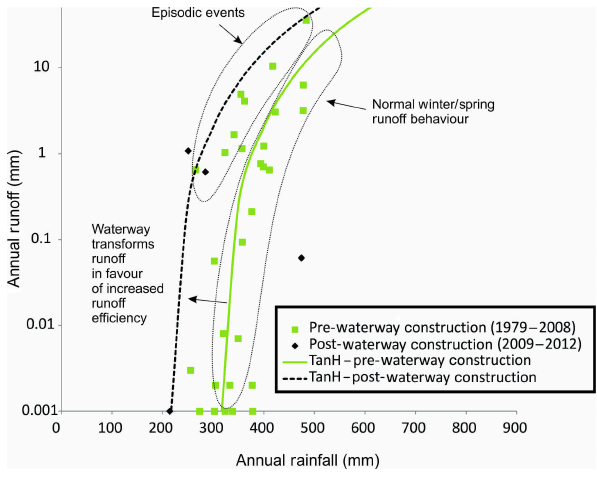
Figure 5. The annual rainfall–runoff data show the role that micro- topography plays within low-gradient drylands, with a pronounced change in runoff efficiency recorded at the long-term gauge after the construction of the waterway through the Dulbinning Nature Reserve in